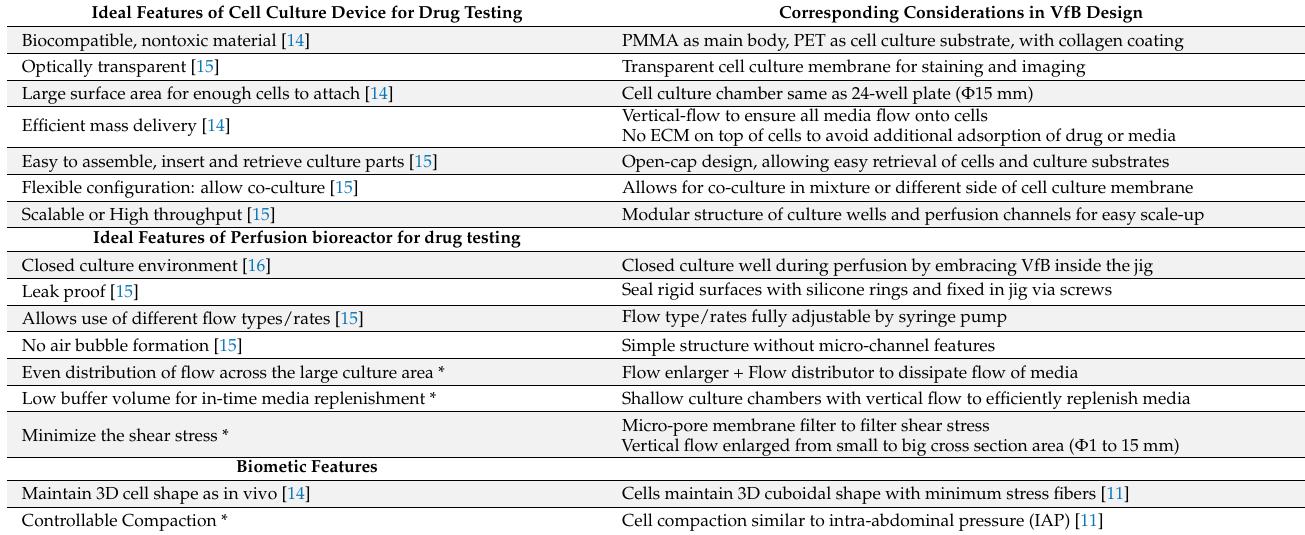
Table 1. Considerations in VfB to meet with the ideal features of cell culture device and bioreactor. Ideal Features of Cell Culture Device for Drug